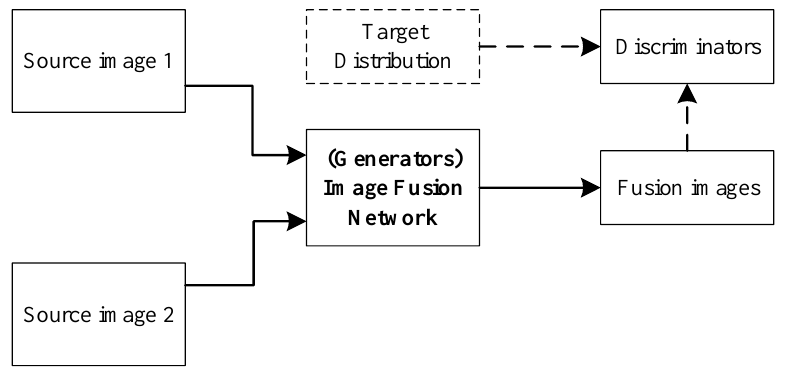
Figure 5. GAN-based image fusion framework.